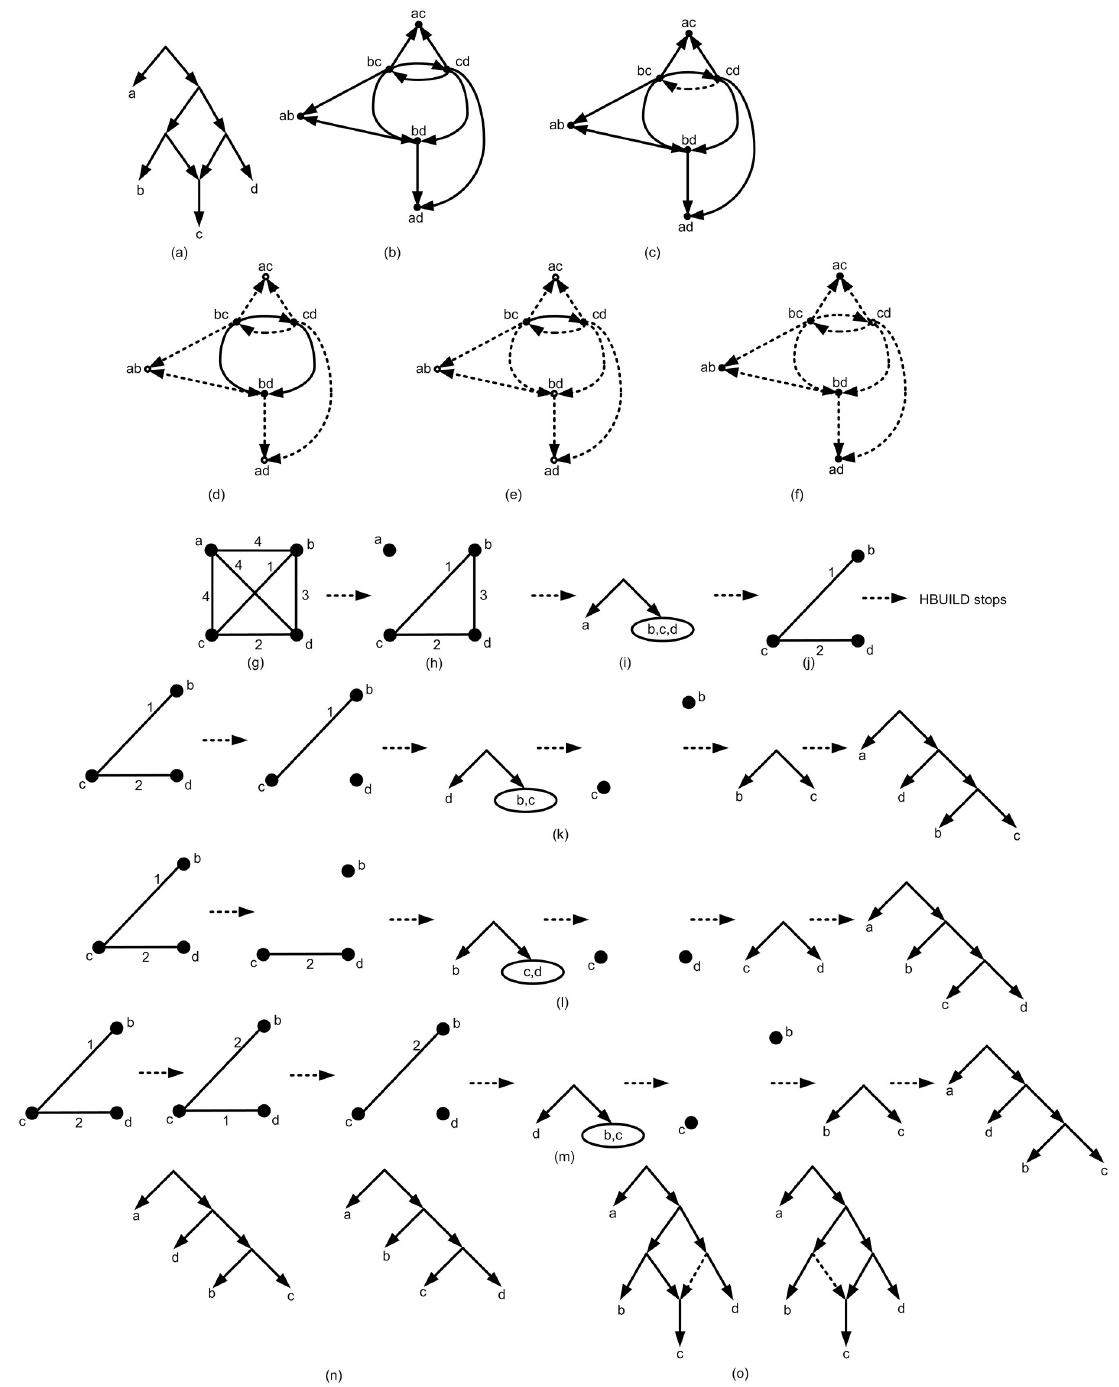
Fig 15. A basic tree structure construction process for a given τ = { bc | a , bd | a , cd | a , bc | d , cd | b . τ is not consistent with a tree and HBUILD stops in some steps. (a) τ is obtained from the given network and the network is the optimal network consistent with τ . (b) G related to τ . (c) G τ is not a DAG and contains a cycle. The edge ( cd , bc ) is removed to obtain a DAG. For simplicity the new DAG is called ¼ 3 . (d) The nodes ab , ac , ad with out-degree zero and their related edges are removed. h ( a , b ) = h ( a , c ) = h ( a , d ) = 4. (e) The G τ again. l G t node bd with out-degree zero and its related edges are removed. h ( b , d ) = 3. (f) The node cd with out-degree zero and its related edges are removed. h ( c , d ) = 2. Finally the node bc with out-degree zero is removed. h ( b , c ) = 1. (g) The graph ( G , h ) based on the obtained h related to G . (h) The edges with maximum weight are removed from ( G , h ). The resulting graph is disconnected. So HBUILD τ